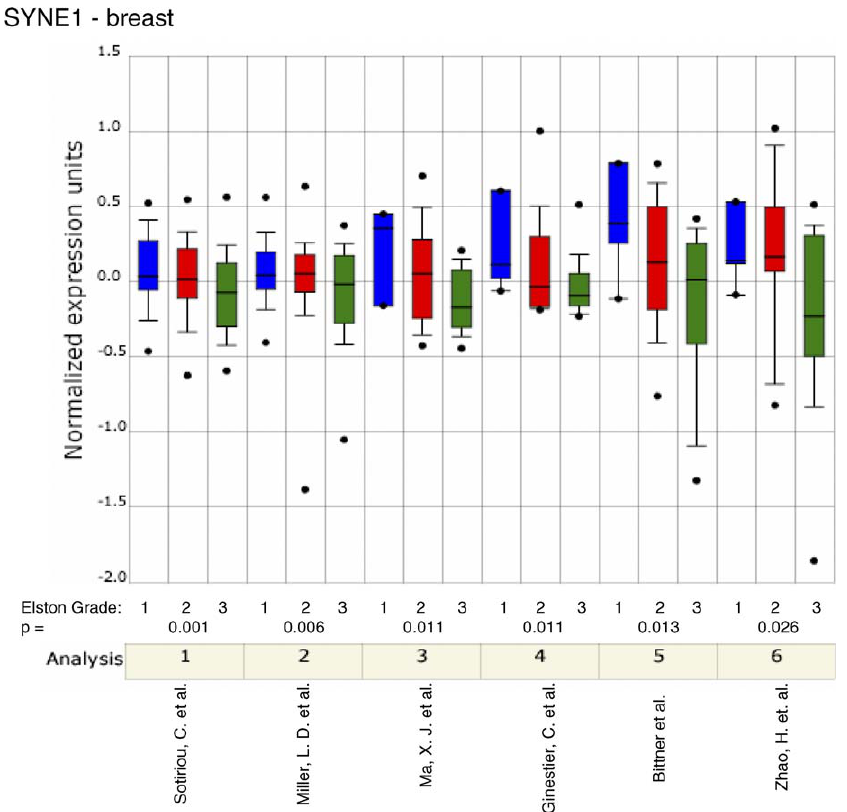
Figure 12. SYNE1 Expression Is Decreased with Increasing Tumor Grade in Breast Carcinoma Representative data are shown across multiple independently published microarray studies as indicated. p -Values for correlation are shown below. References refer to those listed in Table S2.